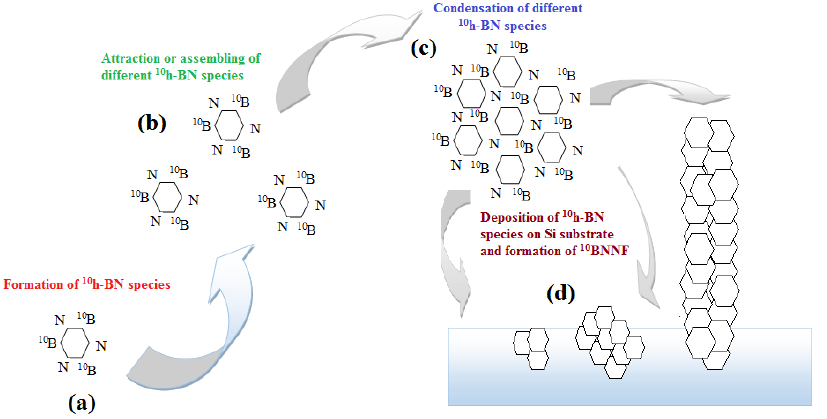
Figure 3. A sketch showing different growth stages ( a – d ) of the as-synthesized 10 BNNFs.